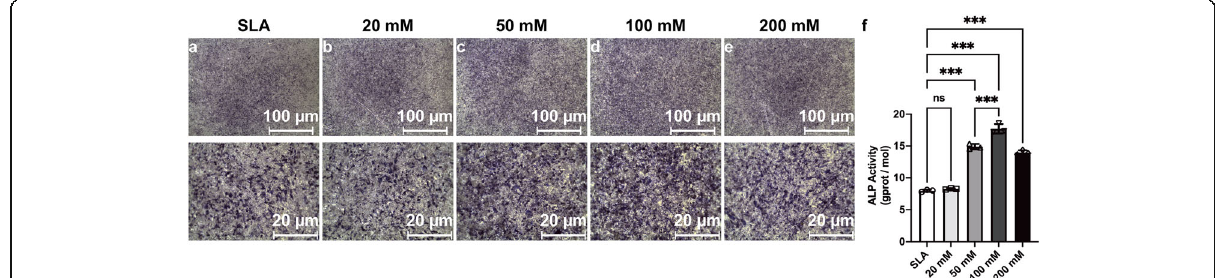
Fig. 8 ALP staining images of BMSCs cultured on SLA surfaces ( a ) and SLA discs treated with 20 mM ( b ), 50 mM ( c ), 100 mM ( d ), or 200 mM ( e ) sodium bicarbonate after cell osteogenic differentiation for 7 days. Quantitative results of the relative activity of ALP in BMSCs on different surfaces after 7 days ( f ). Data are presented as the mean ± standard deviation ( n = 3, * P < 0.05; ** P < 0.01; *** P < 0.001)